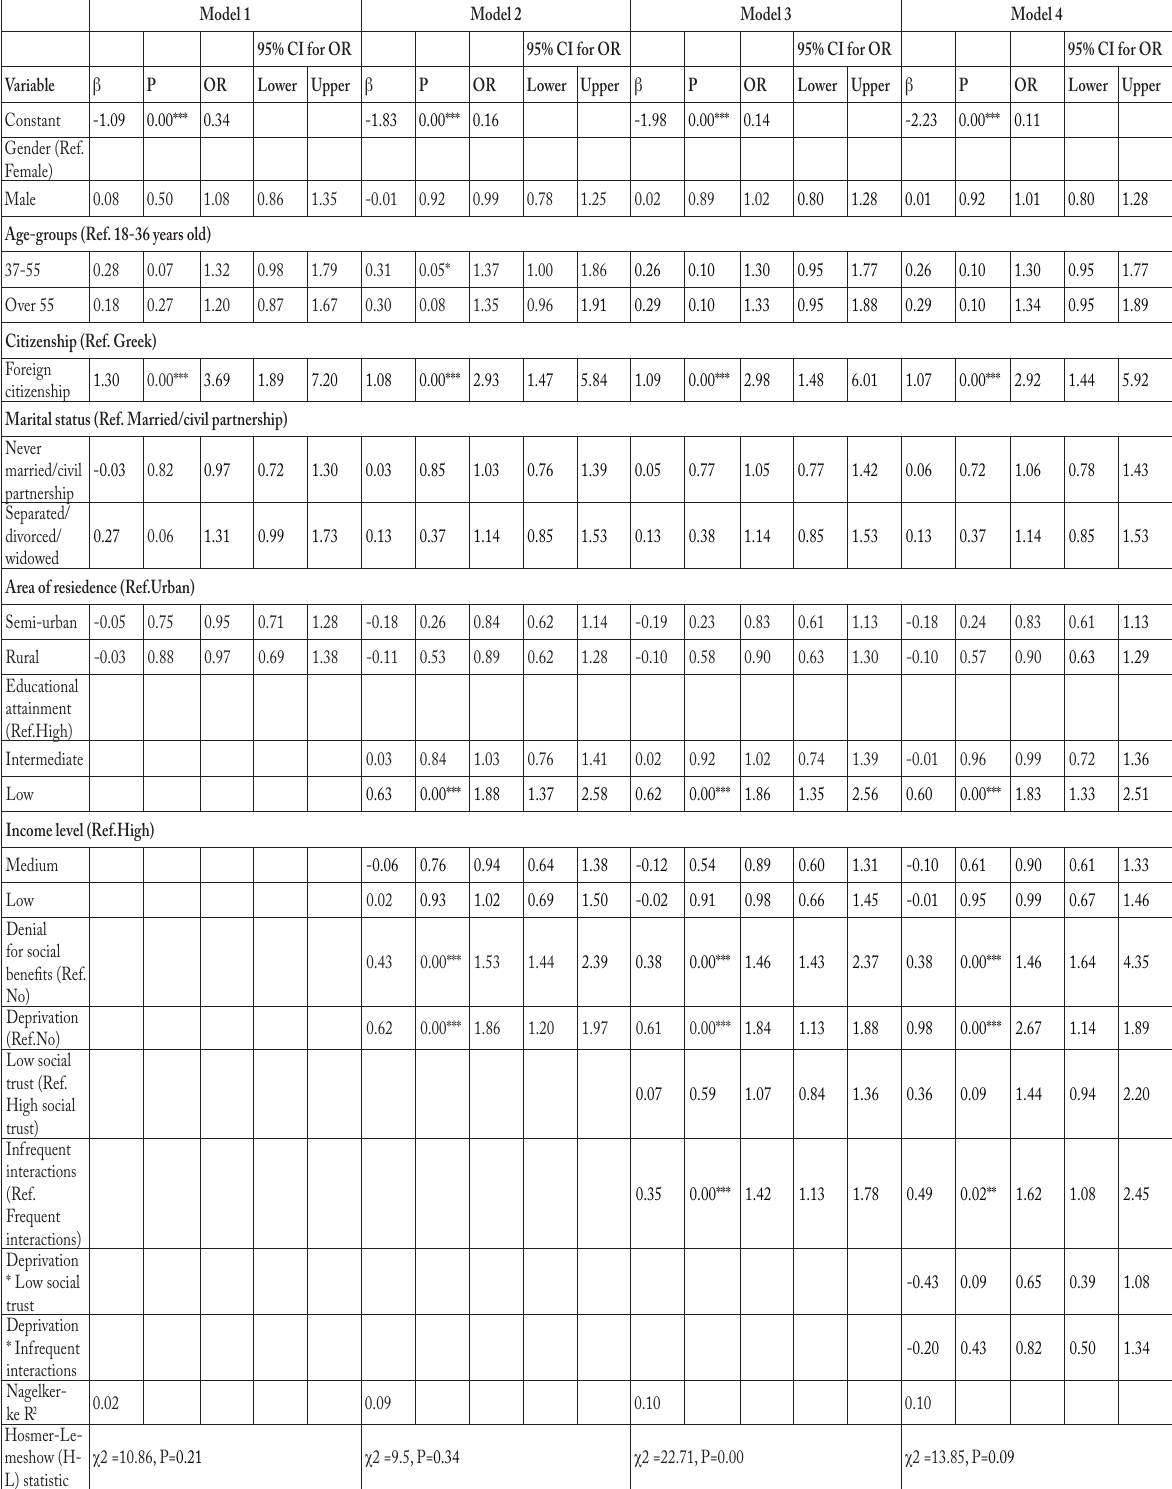
Table 3. Binary logistic regression analysis for predicting poor self-rated health in Greece (n = 1,572). Model 1 Model 2 Model 3 Model 4 95% CI for OR 95% CI for